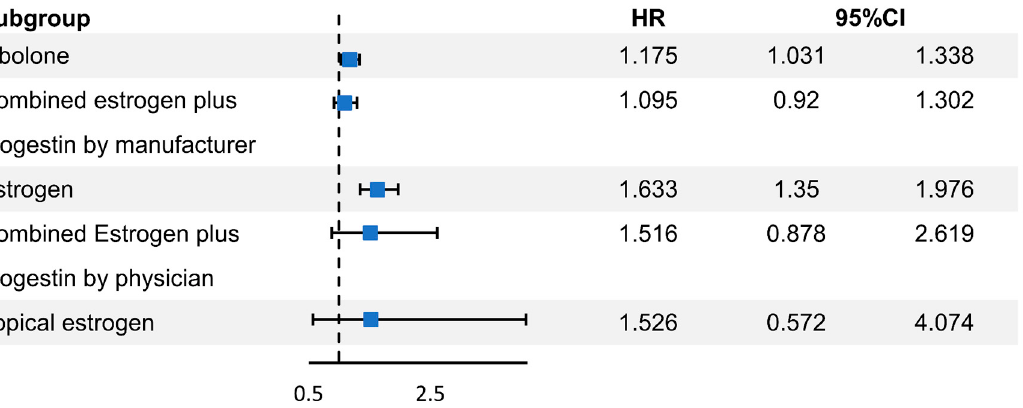
Figure 2. Hazard ratio for risk of oral cancer according to MHT.